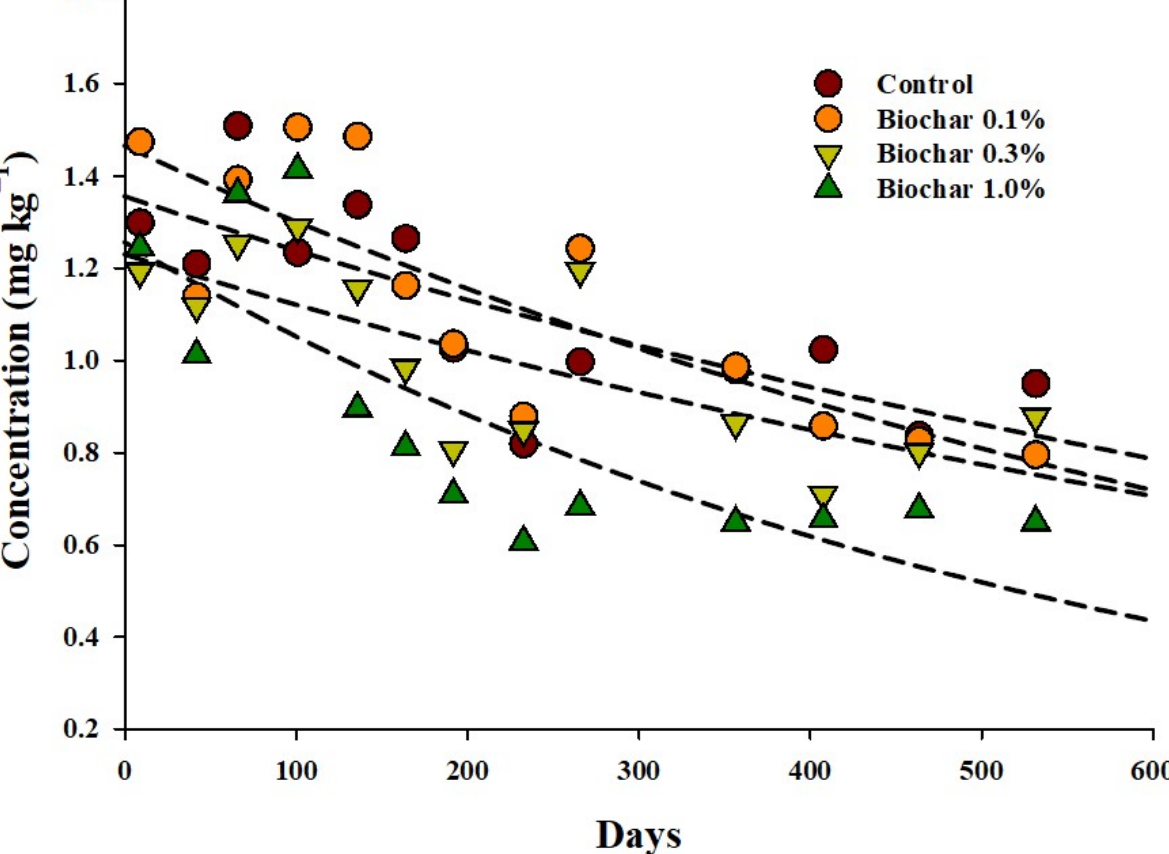
Figure 3. Comparison of the residual dissipation pattern of total endosulfan for different biochar